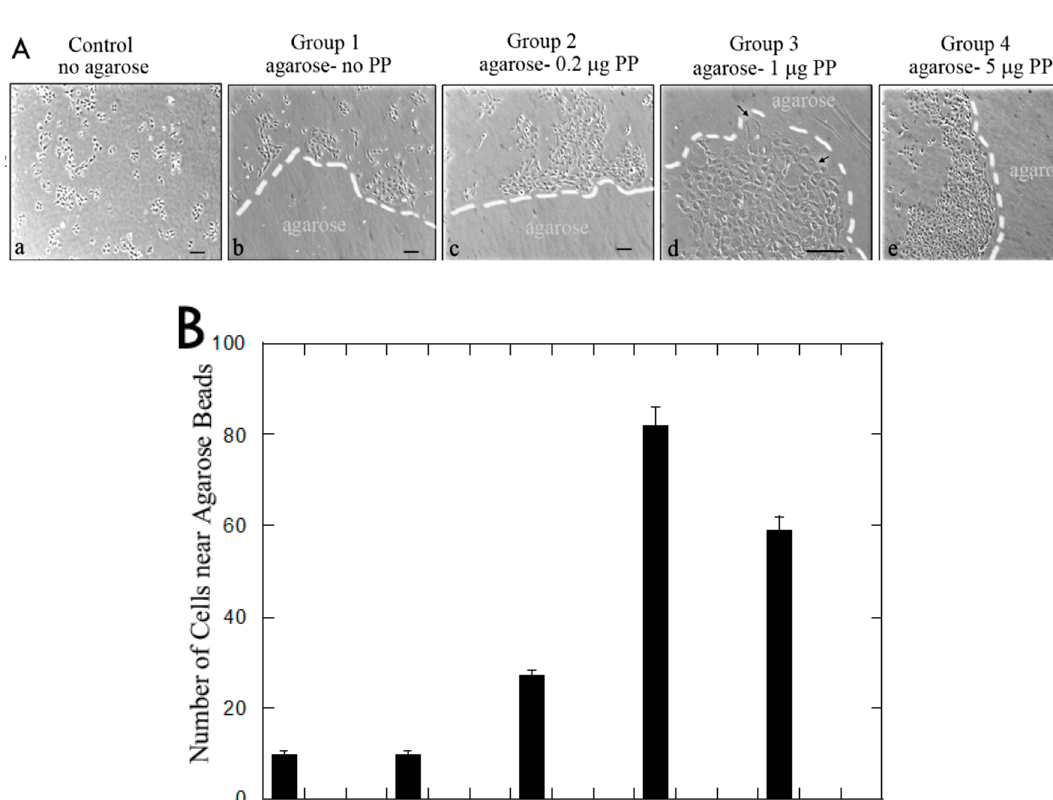
Figure 2. ( A ) Rat dental pulp MRPC-1 cell migration on Day 2:( a ) scattered distribution of pulp cells in control group (i.e., no agarose in the well); ( b ) Group 1 (agarose-no PP), cells scattered around the agarose gel; ( c ) Group 2 (agarose-0.2 μ g PP), cells slightly clustered around the agarose gel; ( d ) in Group 3 (agarose-1 μ g PP), more cells were around the gel and wide spread cytoplasm was noted (indicated by arrows); and ( e ) in Group 4 (agarose-5 μ g PP), more cells circled the gel. White dashed lines represent the boundary between cells and agarose bead. Scale bar = 100 µ m for all frames. ( B ) Cell migration: Data from cell migration from each group are represented here as a bar graph. Error bars represent S.E. ( n = 3).